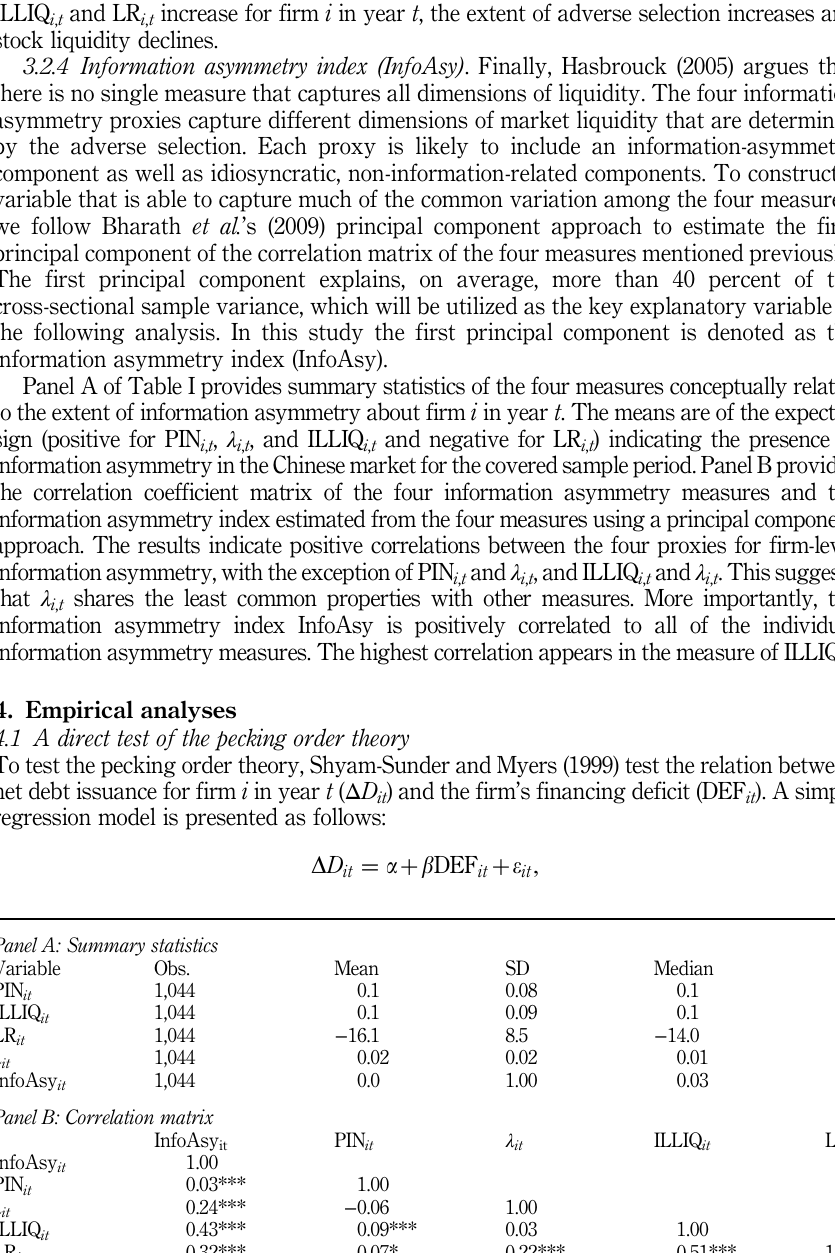
Table I. Summary statistics and correlation matrix on asymmetric information